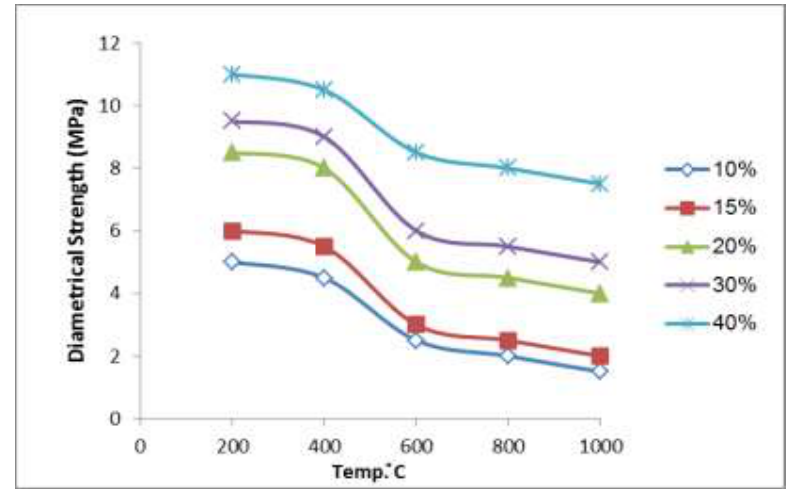
Figure 7: Diametrical Strength for bentonite